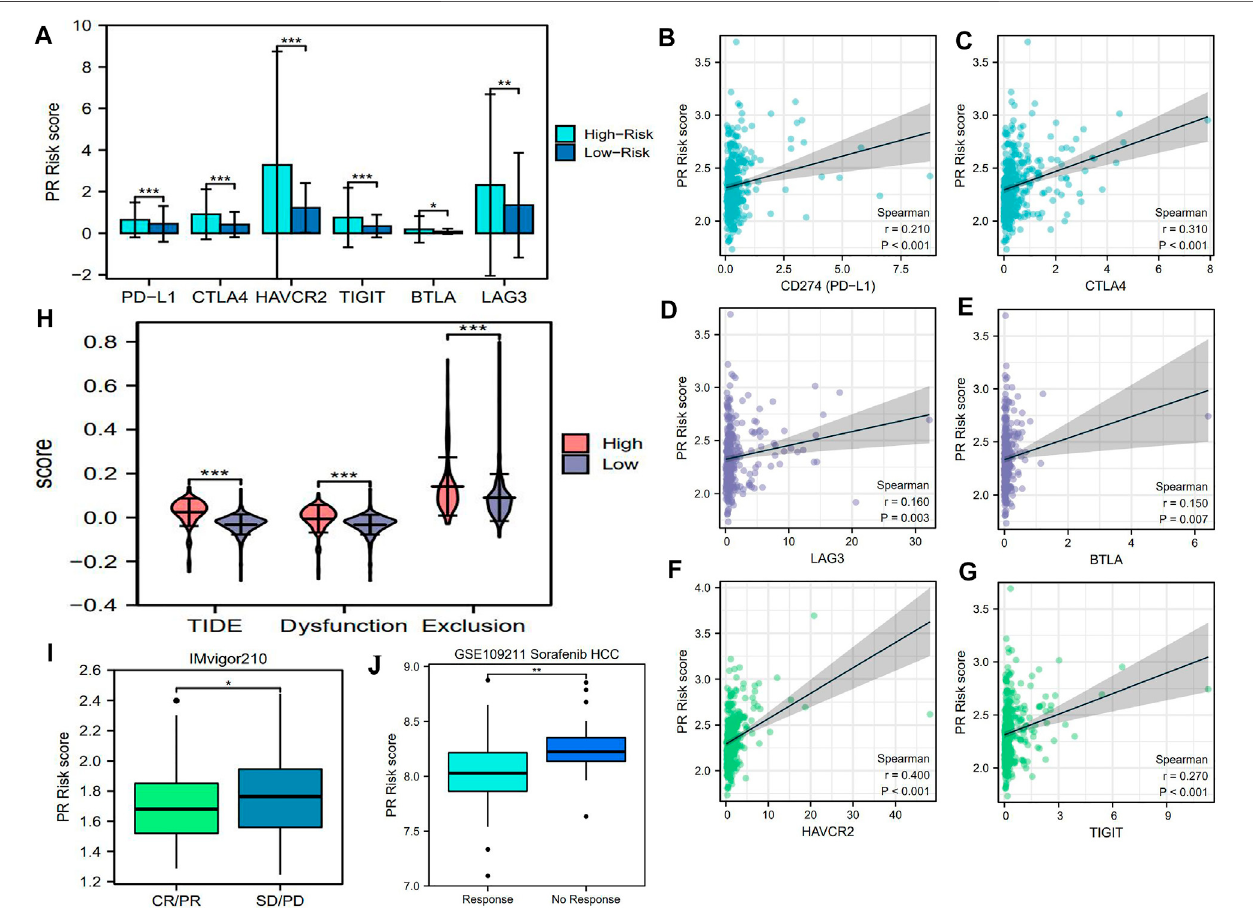
Frontiers in Genetics |